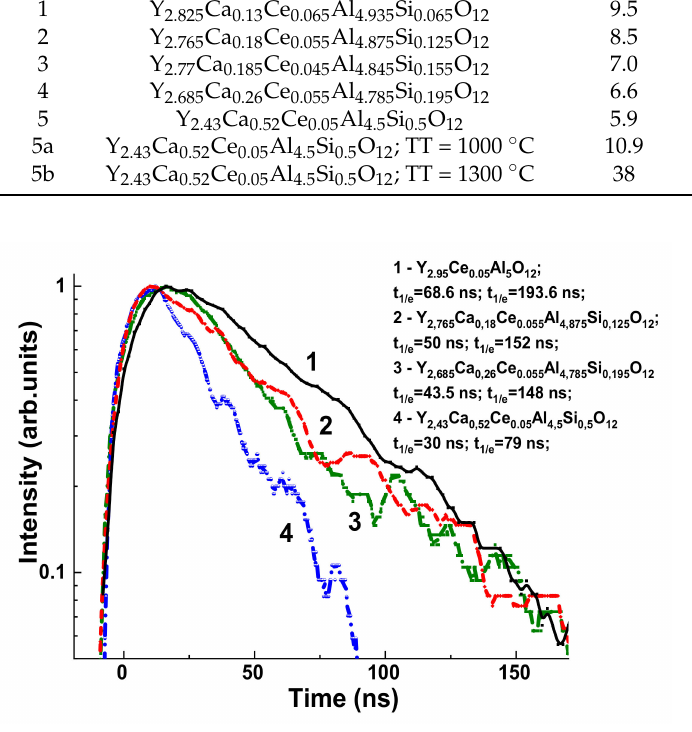
Figure 9. Scintillation decay kinetics of Y 3 − x Ca x Al 5 − y Si y O 12 :Ce SCFs with different Ca and Si content under excitation by α –particles of 239 Pu (5.15 MeV) source in comparison with respective scintillation decay kinetics of YAG: Ce SCF